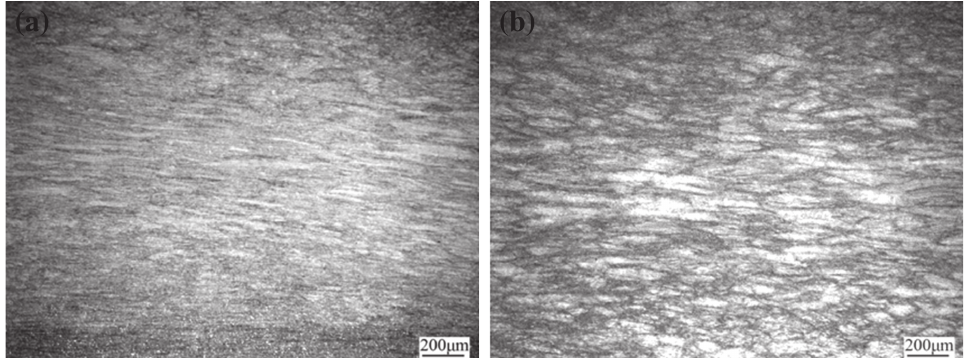
Figure 3: Microstructures with flow instability deformed at conditions of: (a) 1,233 K, 10 s – 1 ; (b) 1,253 K, 10 s – 1